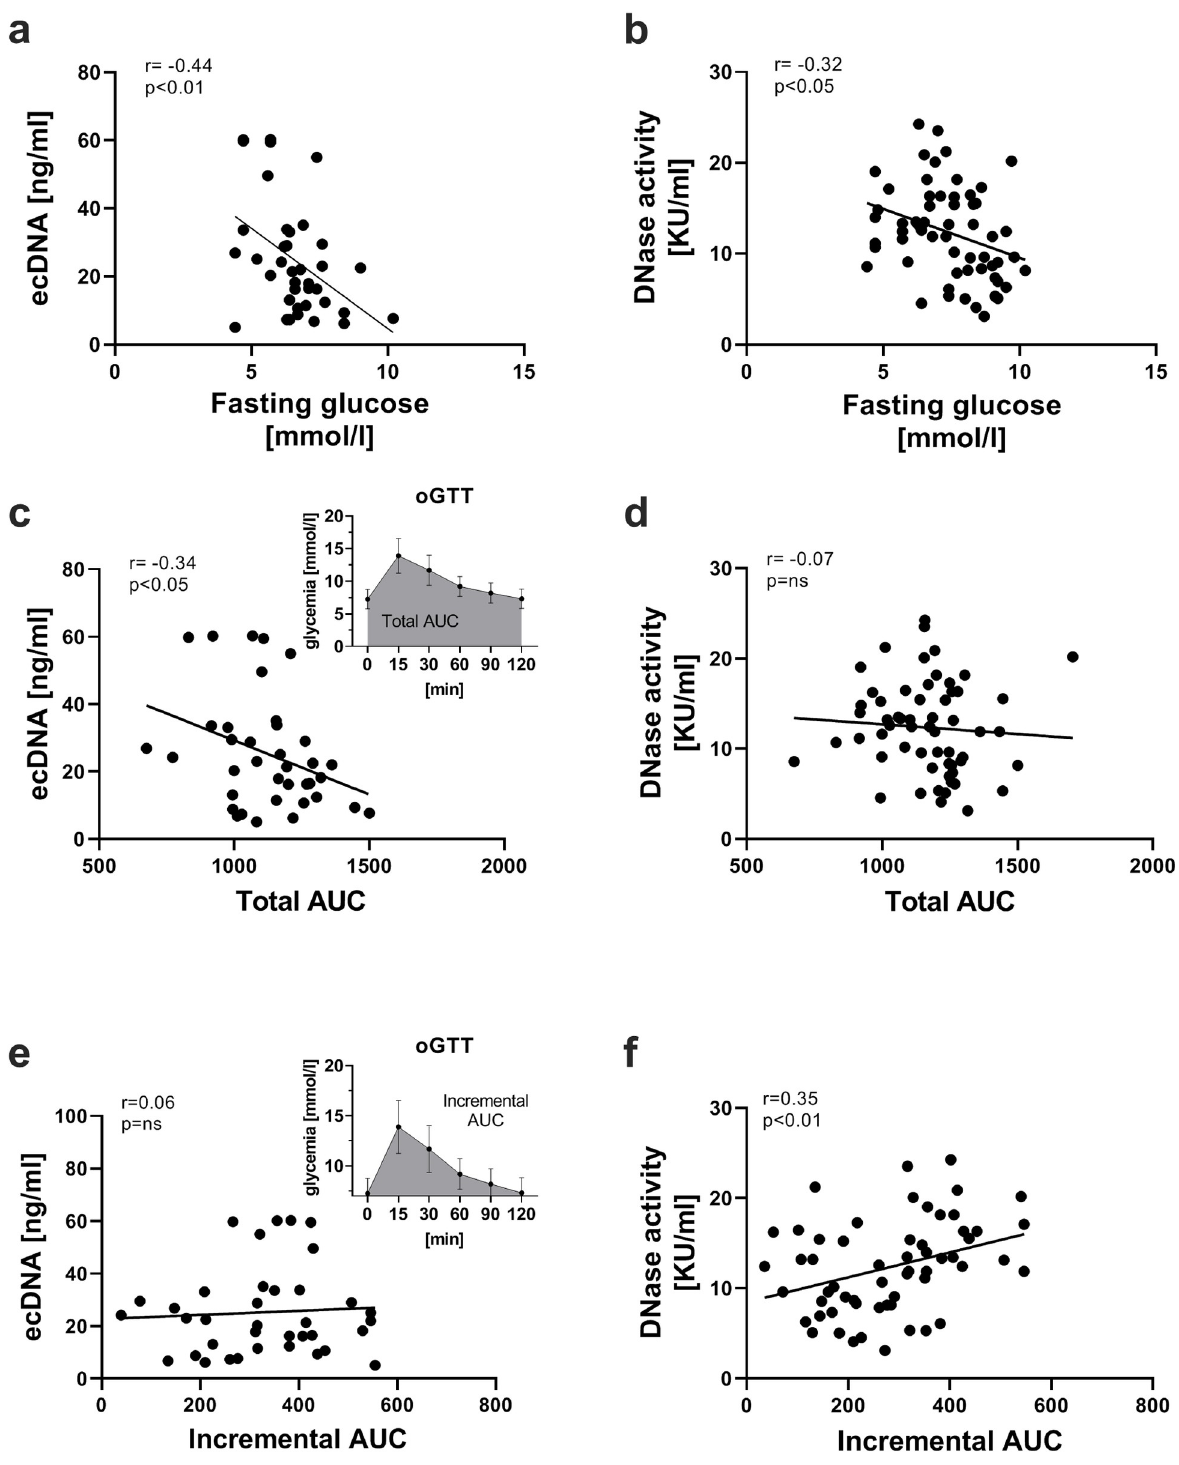
Fig 2. Relationship of ecDNA and DNase activity with fasting glucose, total and incremental AUC. Correlations between ecDNA and fasting glucose (a), total AUC (c) or incremental AUC (e). Correlations between DNase activity and fasting glucose (b), total AUC (d) or incremental AUC (f). ecDNA—extracellular DNA; AUC—area under the curve; KU—Kunitz units.